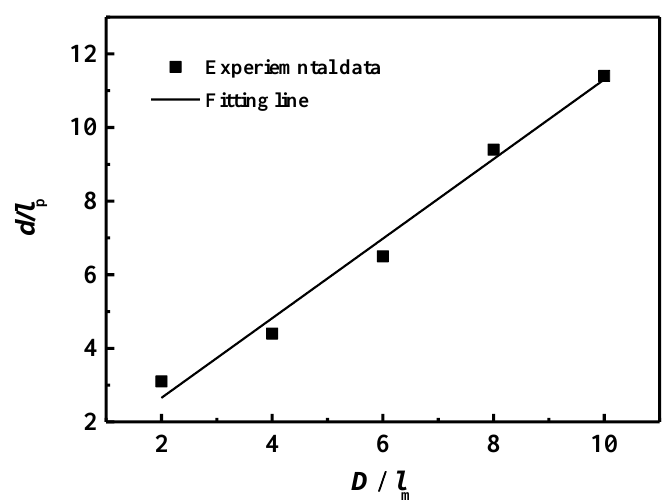
Figure 13. The defect size vs. the value of model parameter d .